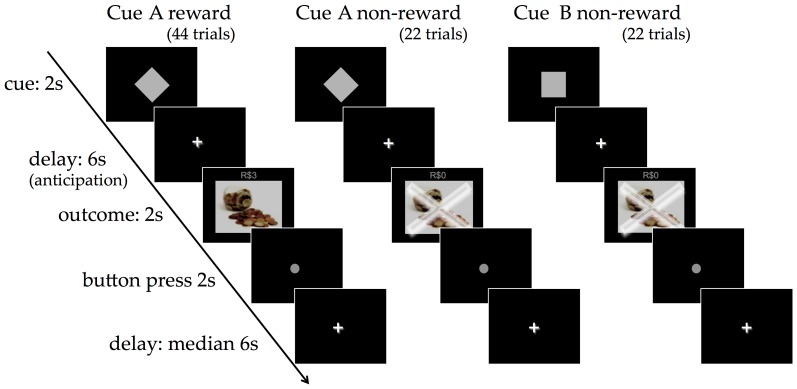
Classical conditioning fMRI paradigm.One of two neutral stimuli (Cue A or Cue B) was followed by an outcome stimulus (reward or non-reward) after a 6-second delay. Cue A was followed by the delivery of the reward 66% of the time and non-reward 33% of the time. Cue B was always followed by non-reward. Participants were told they would receive the equivalent of R$3 for each reward outcome. The length of the inter-trial delay was varied.